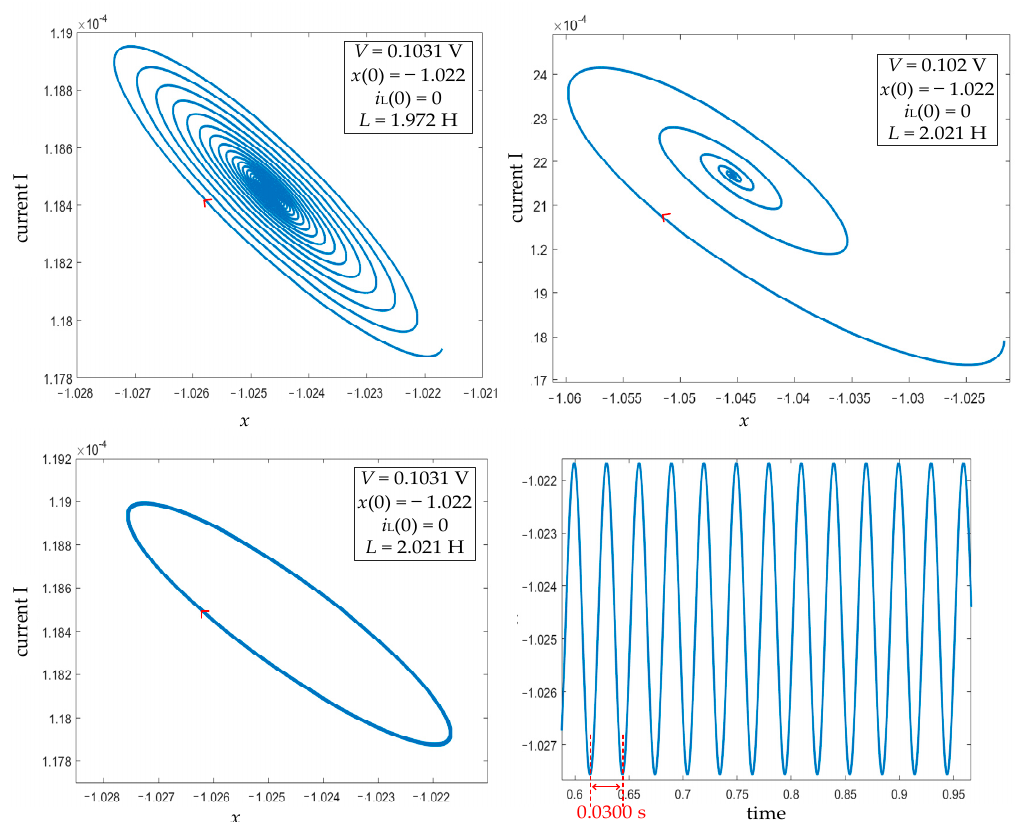
Figure 14. Simulation of memristor oscillation circuit (if V = 0.1031 V and x = − 1.022).